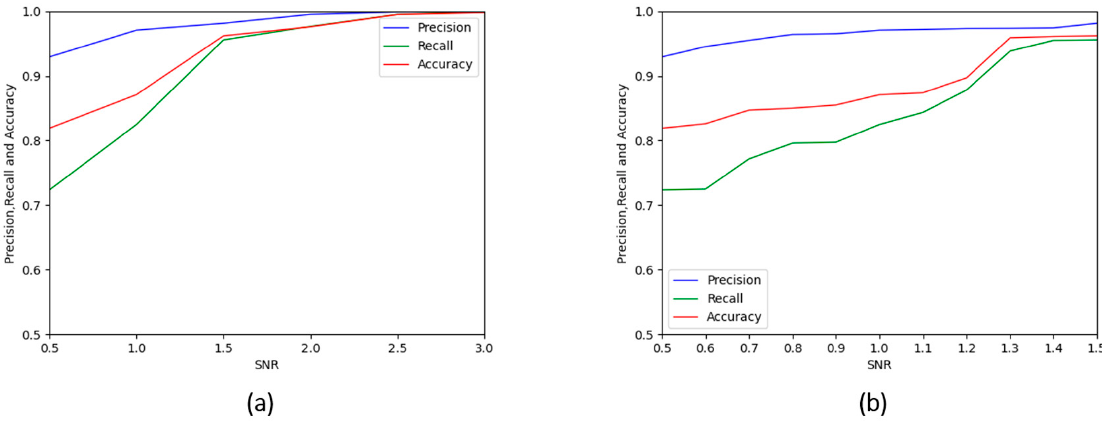
Figure 13. The detection effect of this method under different SNRs. ( a ) is the result from 0.5 to 3 dB. ( b ) is the result from 0.5 to 1.5 dB. Table 3. Test results with an interval of 0.1 dB.